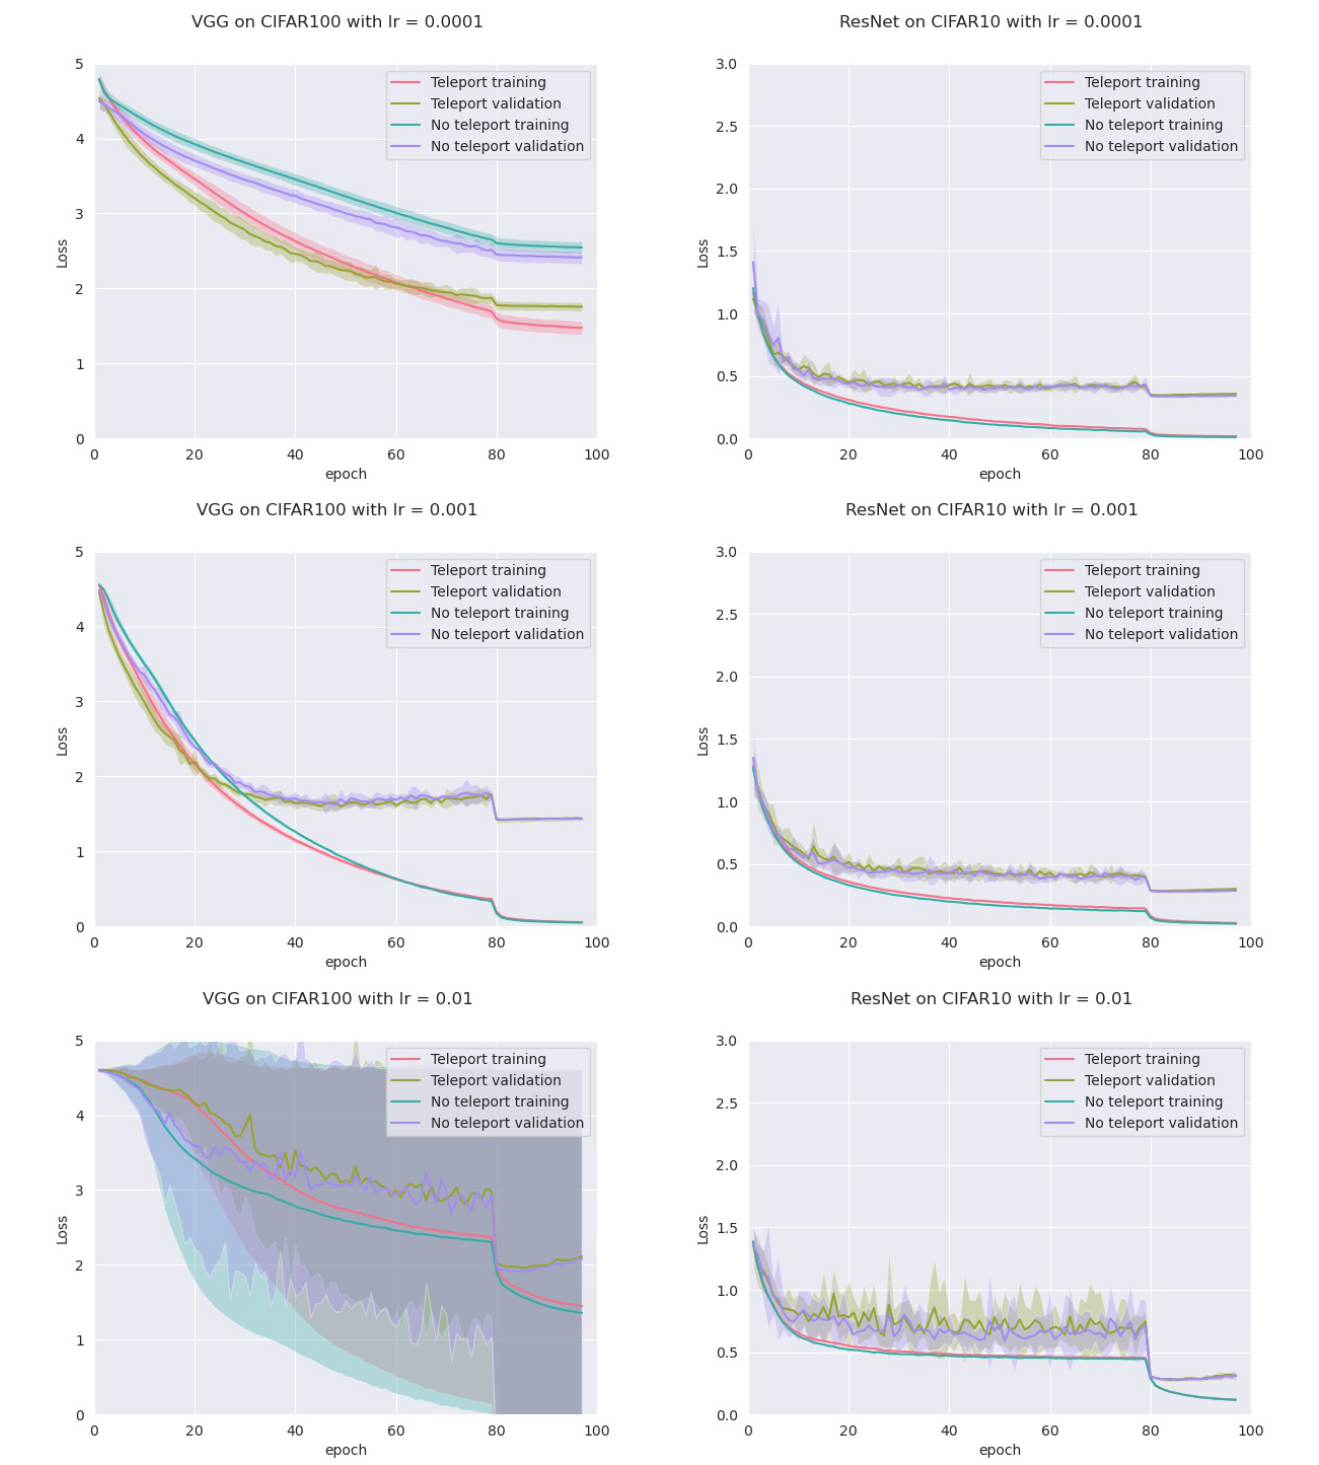
Figure A10. Average loss of VGG with normal initialization on CIFAR100 ( left ) and ResNet with Xavier initialization on CIFAR10 ( right ) both training with SGD with momentum over 5 experiments for each, with and without teleportation, at the beginning of the training with CoB of 0.9. Learning rate increases from top to bottom rows. We also show a shadow around the average curves at two times the standard deviation over the five